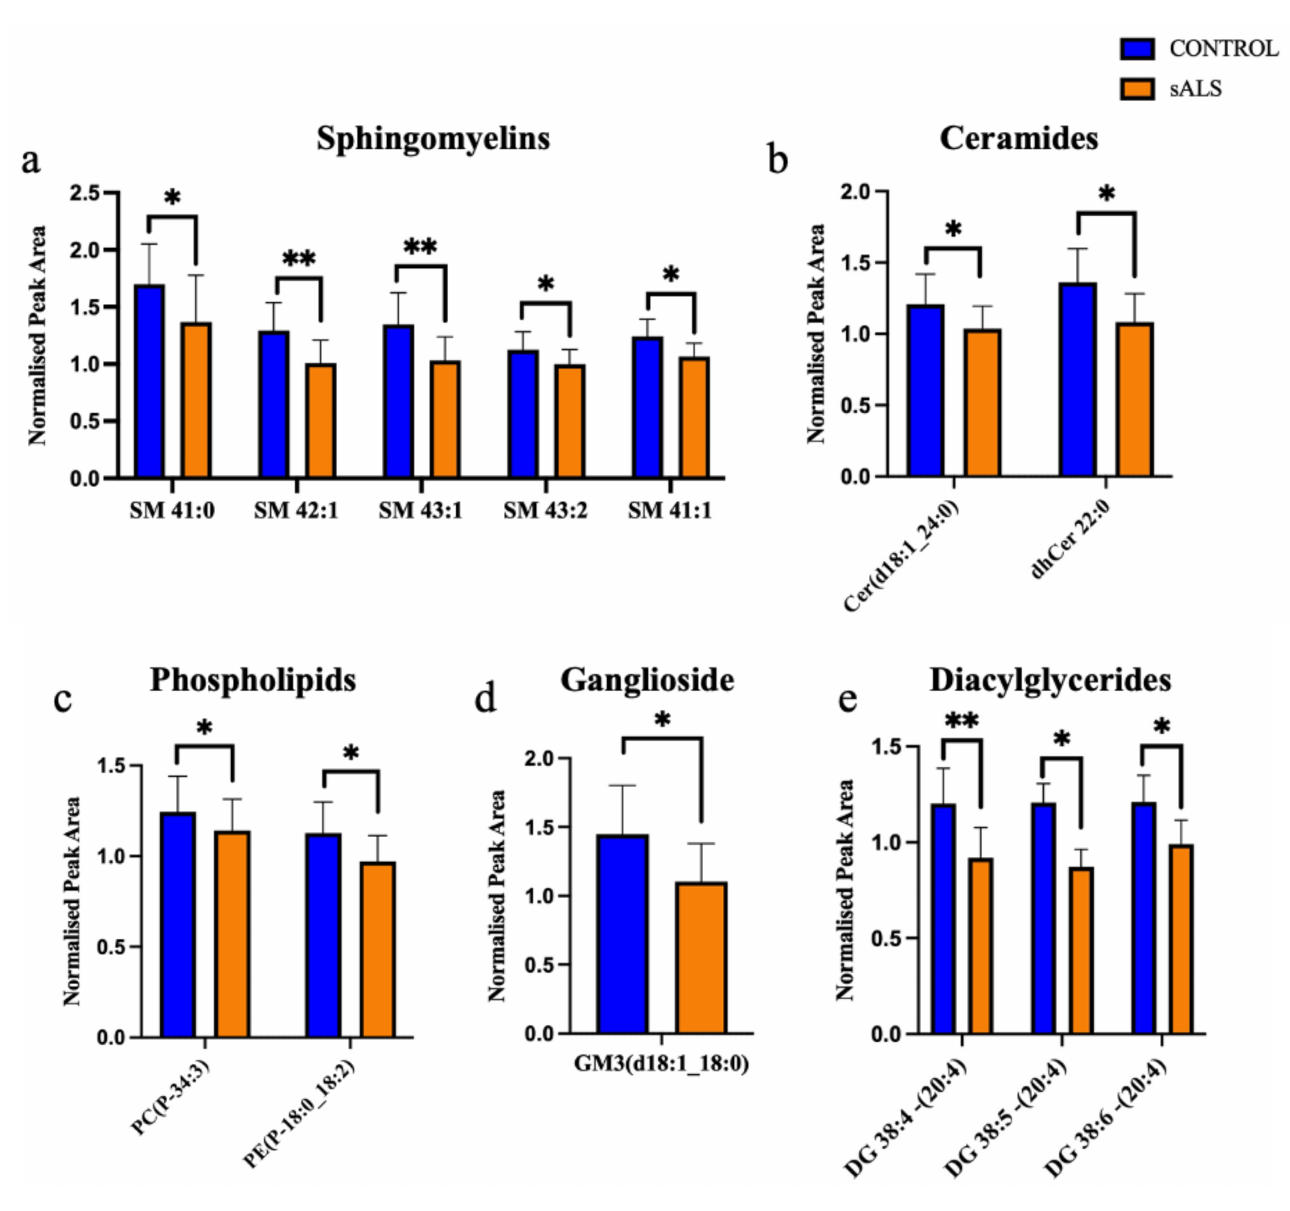
Figure 3. Ceramides, glycerolipid, phospholipids and sphingomyelin are decreased in ALS compared to control in the motor cortex white matter. ( a ) Sphingomyelins (SM); ( b ) ceramides (Cer); ( c ) phos- phatidylcholine (PC) and phosphatidylethanolamine (PE); ( d ) ganglioside (GM); ( e ) diacylglycerides (DG) have a significantly decreased normalised peak area in ALS (orange; sALS n = 8) compared to control (blue; n = 8); * p < 0.05; ** p <